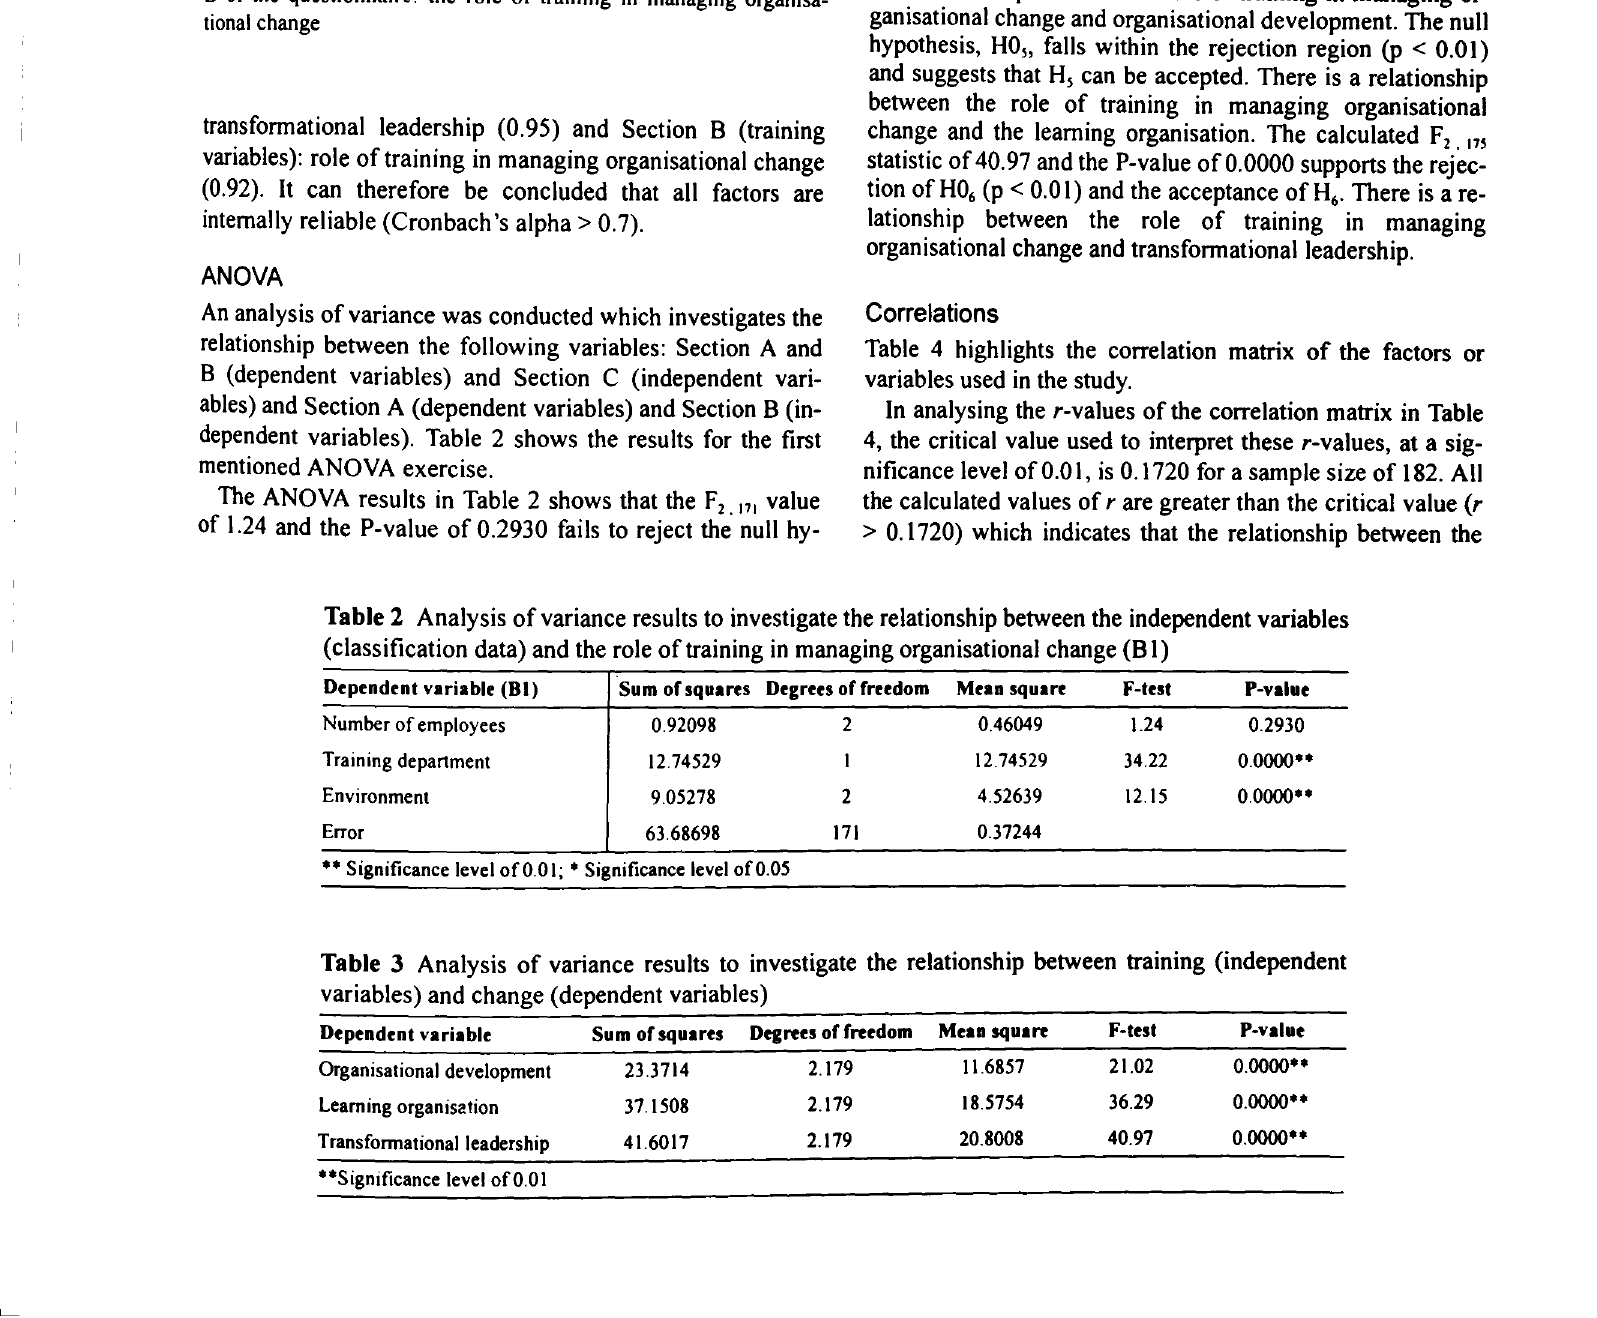
Figure 3 Histogram of the frequency distribution results of Section B of the questionnaire: the role of training in managing organisa tional change